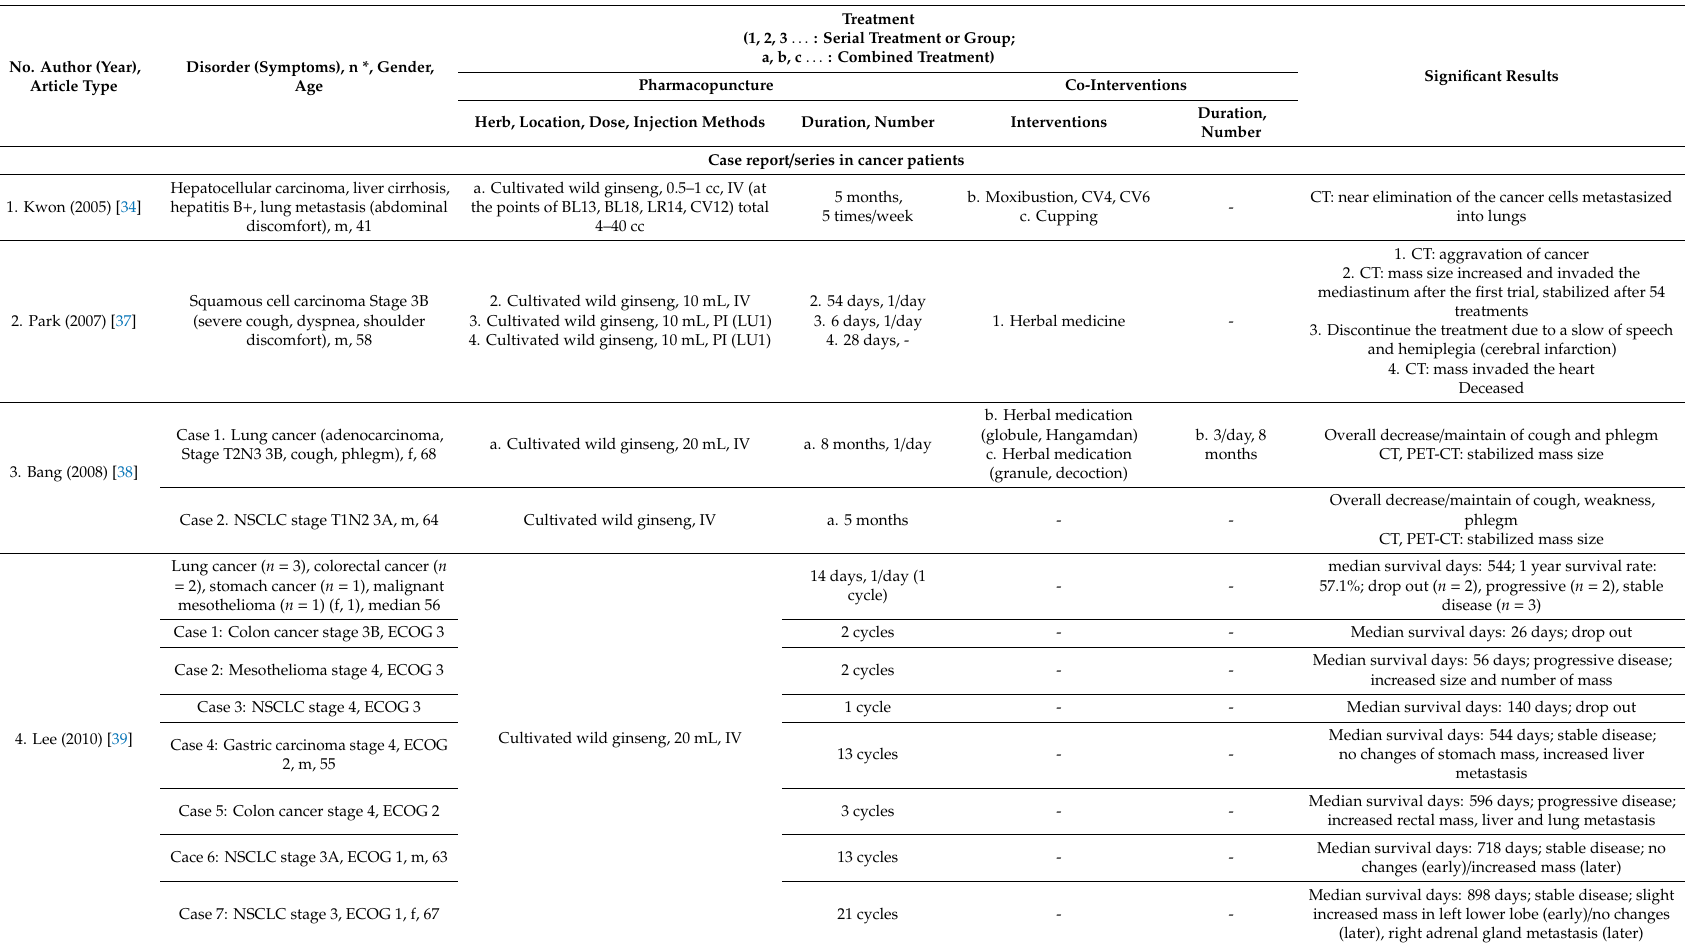
Table 4. Summary of included clinical trials using (wild) ginseng pharmacopuncture in patients with various